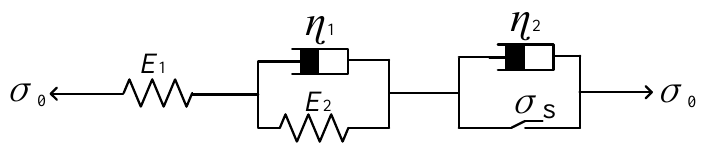
Table 4. Polynomial regression results for E ( x ).